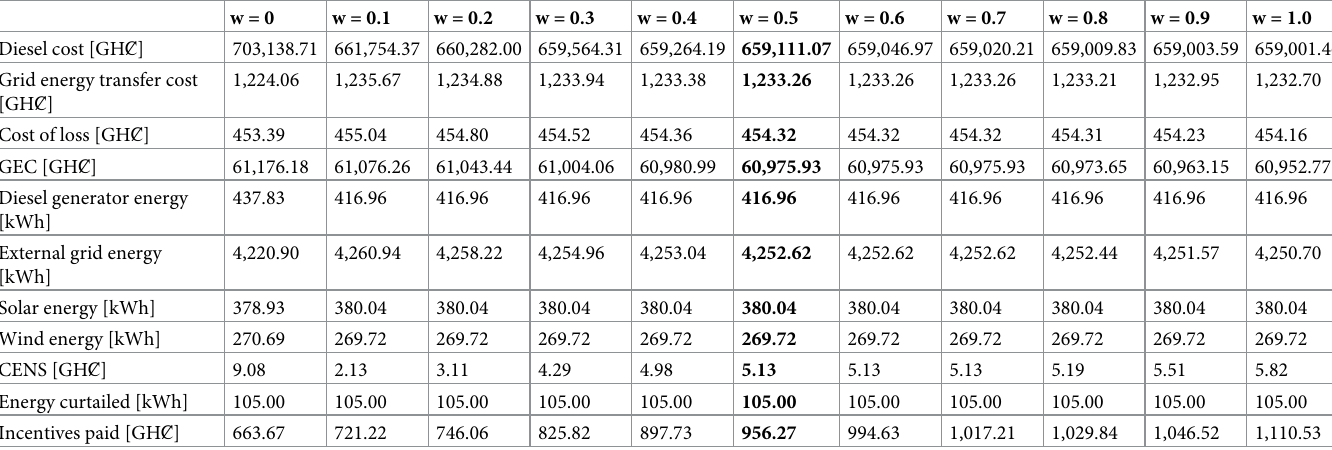
Table 12. Influence of ’w’ on distribution network–case